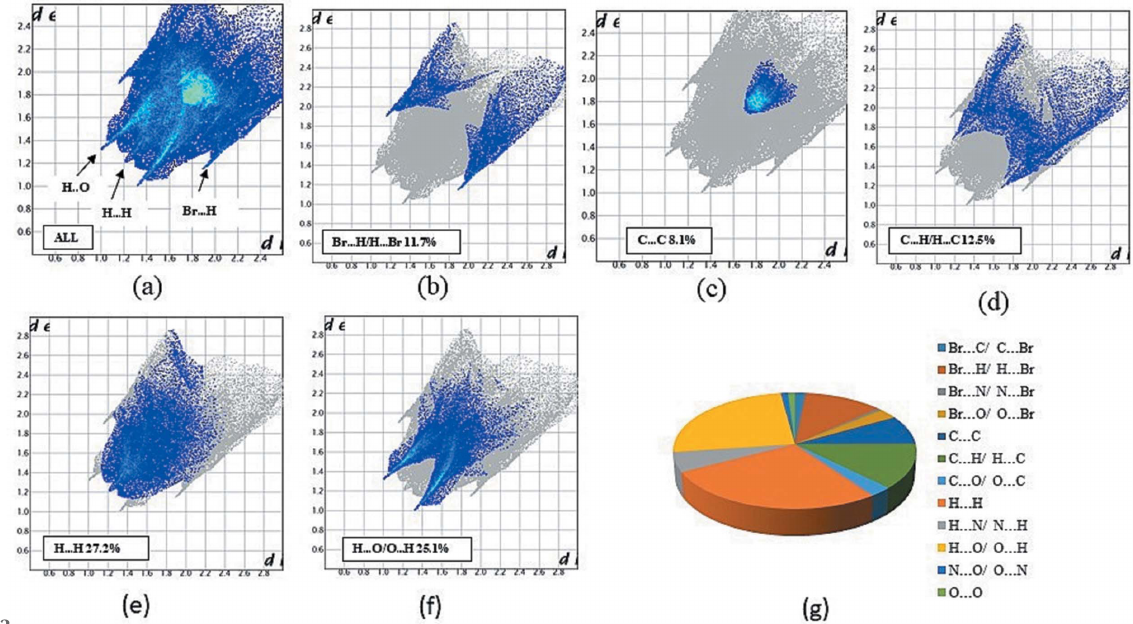
Figure 3 The full two-dimensional fingerprint plots, and those delineated into ( a ) all interactions ( b ) Br (cid:3)(cid:3)(cid:3) H, ( c ) C (cid:3)(cid:3)(cid:3) C, ( d ) C (cid:3)(cid:3)(cid:3) H/H (cid:3)(cid:3)(cid:3) C, ( e ) H (cid:3)(cid:3)(cid:3) H and ( f ) H (cid:3)(cid:3)(cid:3) O/O (cid:3)(cid:3)(cid:3) H contacts showing the percentages of contacts contributed to the total Hirshfeld surface area. ( g ) Pi